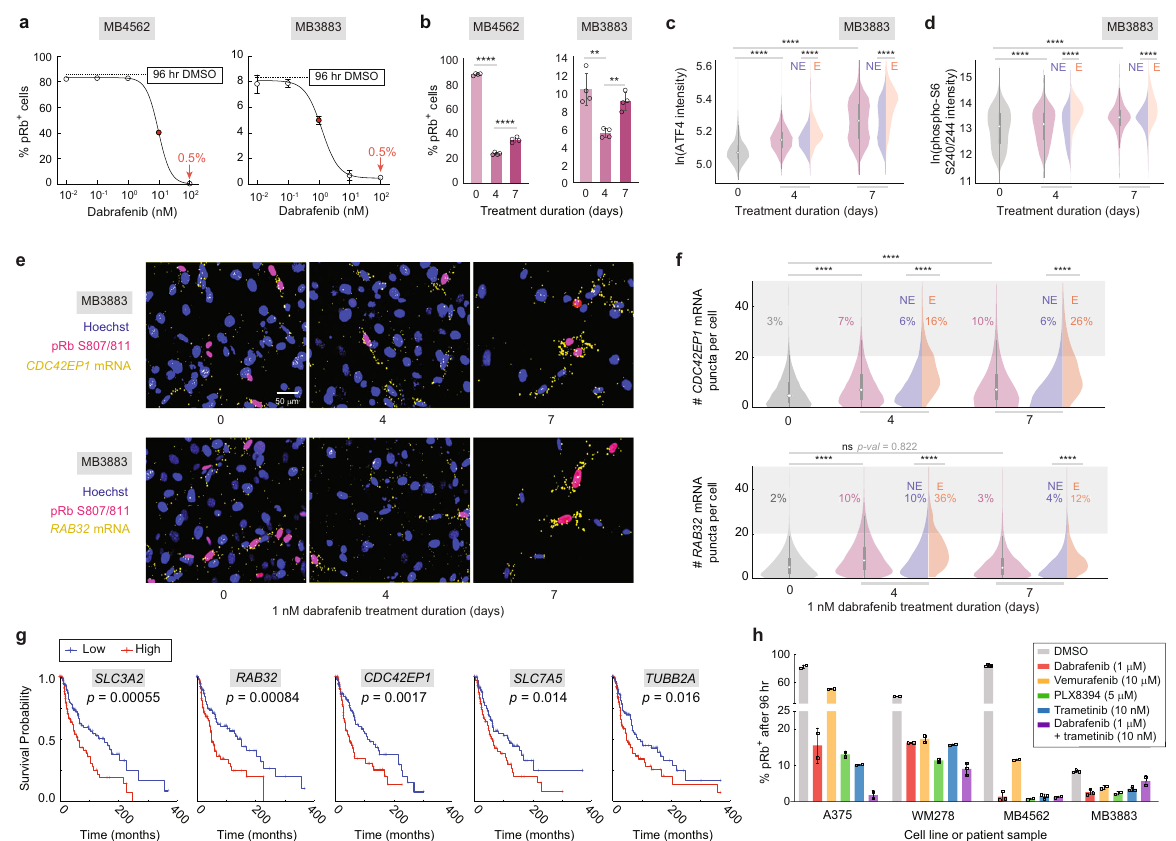
Fig. 6 Existence of escapees and upregulation of ATF4 target genes in clinical samples. a Dose – response curves at 96h of treatment in two ex vivo patient cultures, noting a residual 0.5% of pRb + cells at the highest dose. Approximate IC50 values are displayed as red dots. Error bars: mean ±std of three replicate wells. b Percentage of pRb + cells in the two patient samples treated with IC50 dose of dabrafenib for 4 or 7 days. Error bars: mean ±std of four replicate wells, representative of two experimental repeats. c , d Violin plots showing ATF4 and phospho-S6 (S240/244) levels by immuno fl uorescence in MB3883 patient cells treated with 1-nM dabrafenib for 0, 4 or 7 days. Escapees are identi fi ed by phospho-Rb (S780) or EdU co-staining for ATF4 or phospho-S6, respectively. Each population value is pooled from six replicate wells. e RNA-FISH images for CDC42EP1 and RAB32 with pRb (S807/811) and Hoechst staining, for MB3883 cells cultured in 1-nM dabrafenib for 0, 4 or 7 days. f Violin plots showing the number of CDC42EP1 or RAB32 mRNA puncta in MB3883 cells. The percentage of cells with >20 mRNA puncta is indicated on the plot. Each population value is pooled from two replicate wells. g Melanoma patient survival curves for 5 of 40 genes upregulated in escapees. p value: log-rank test. h Percentage of pRb + cells in A375, WM278 and two ex vivo patient cultures treated with high doses of dabrafenib, vemurafenib, PLX8394, trametinib or dabrafenib plus trametinib for 4 days. Error bars: mean± std of at least two replicate wells, representative of two experimental repeats. Source data are provided as a Source Data fi